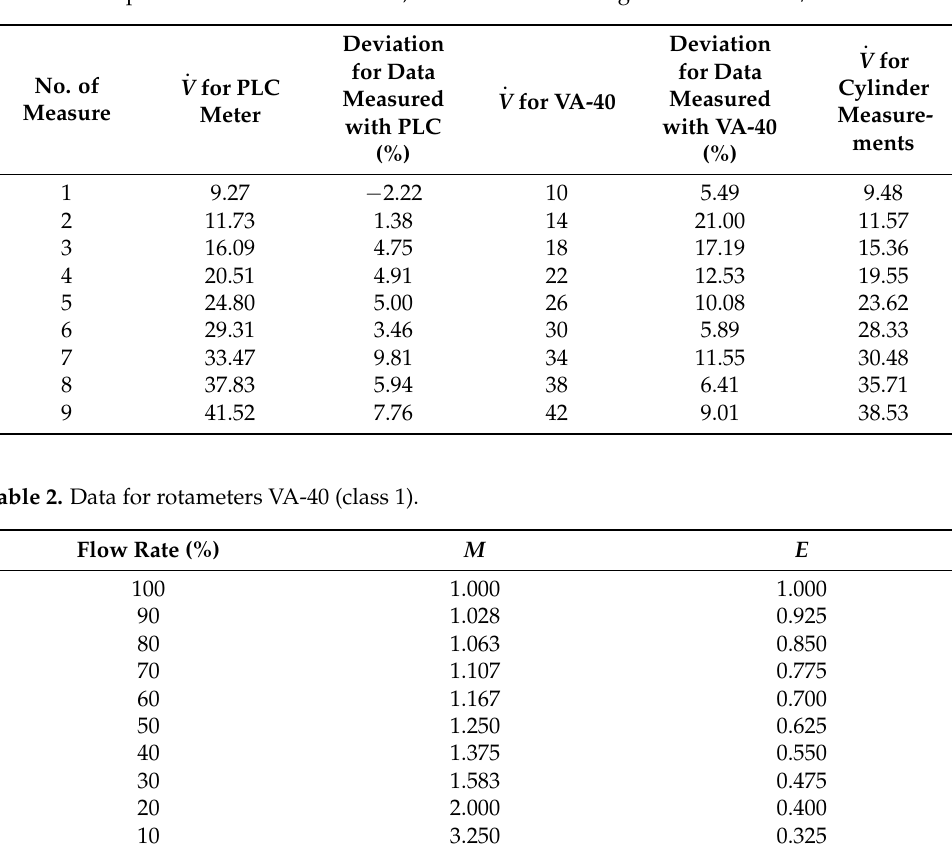
Table 1. Examples of measurement results, where